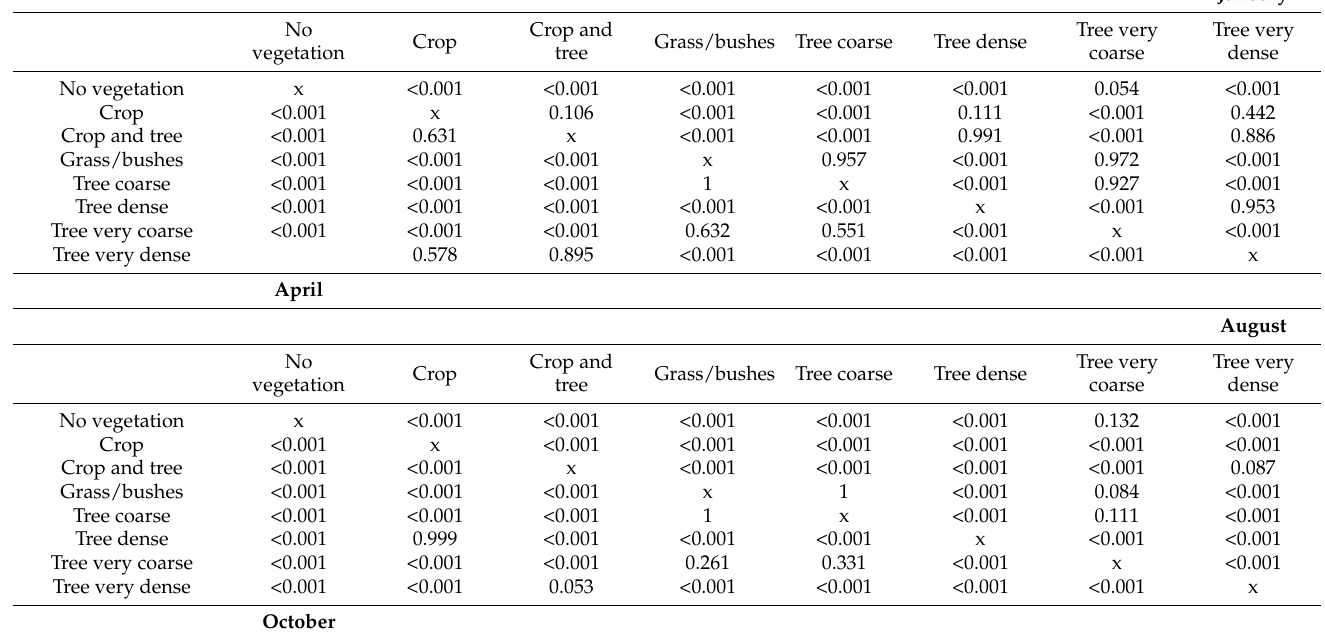
Table 6. Statistics of NDVI values for eight vegetation types (no vegetation, crop, crop and tree, grass/bushes, tree coarse, tree dense, tree very coarse, and tree very dense) in the High Atlas Mountains of Morocco. To separate means a pairwise multiple comparison procedure (Holm–Sidak Method) was